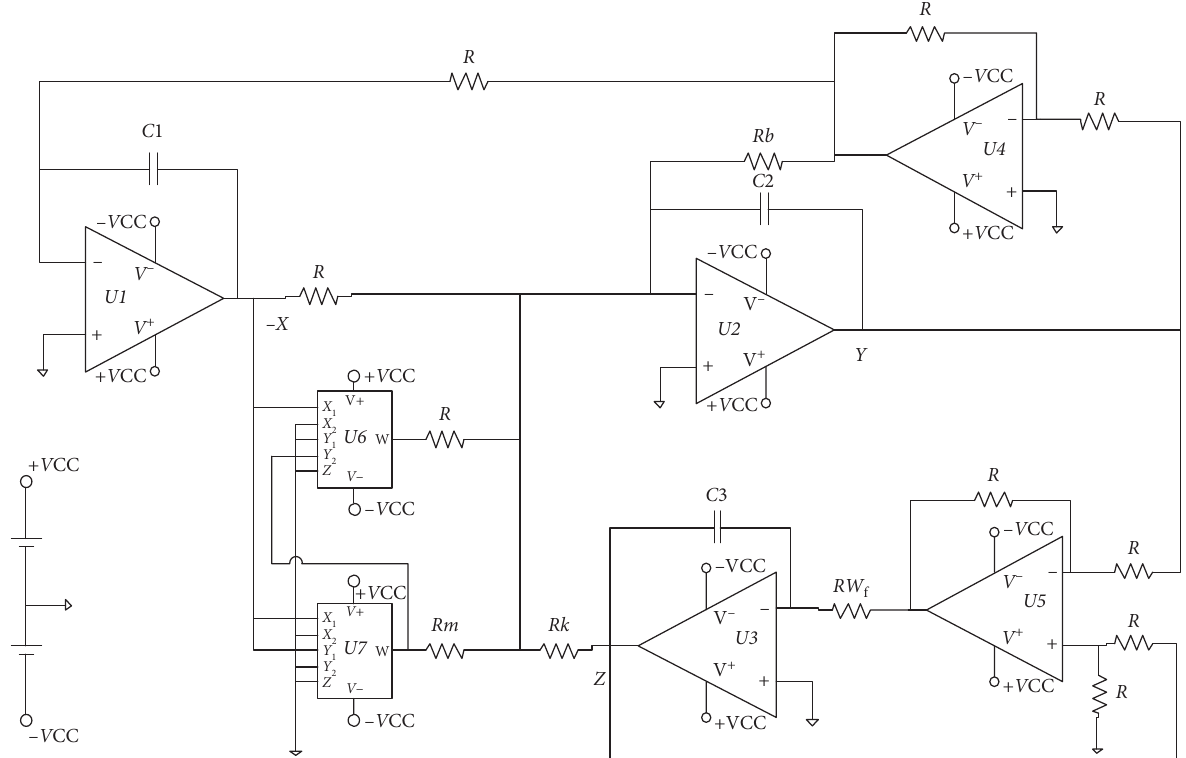
Figure 14: Circuit realization of the three-dimensional autonomous Duffing–Holmes like oscillator described by system (2) where U 1 , 2 , 3 , 4 , 5 ) are TL084CN and U j ( j � 6 , 7 ) are